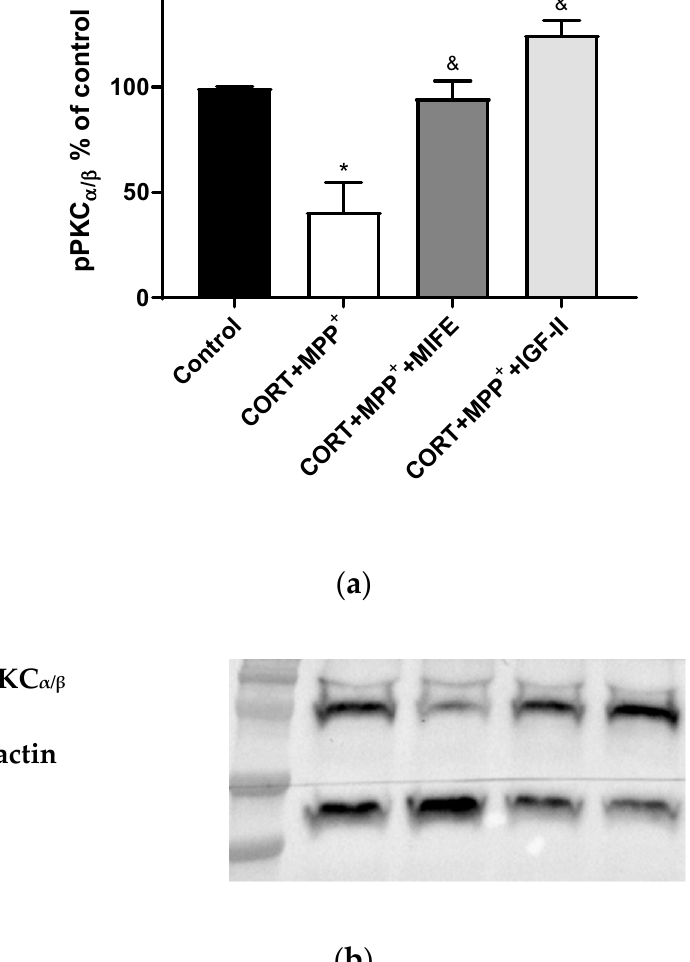
Figure 6. Study of PKC α expression in SN4741 neuronal cells after 2.5 h of incubation with the combination of corticosterone and MPP + (CORT + MPP + ) in the presence or absence of IGF-II. ( a ) Quantification after normalising with β actin; ( b ) Representative Western blot. Data from two independent experiments were combined and presented as mean ± SEM; each situation in each experiment carried out included three independent experiments with three samples in each one; * p < 0.05 com- pared to control cells; & p < 0.05 compared to CORT + MPP + co-incubated cells.